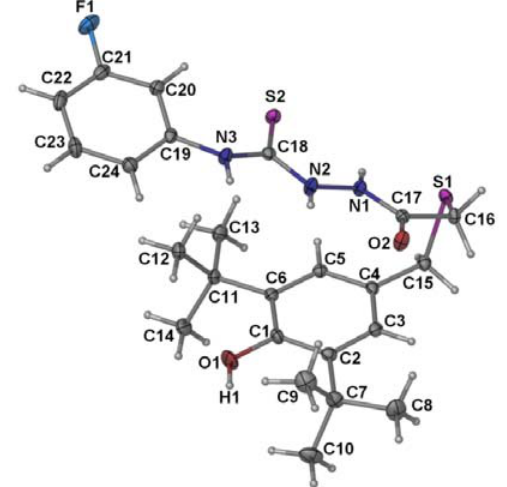
Figure 4. The molecular structures and labeling schemes of 3 (50% probability